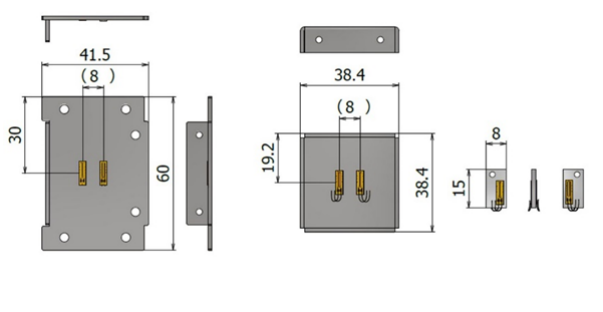
Figure 2. Sensor unit.